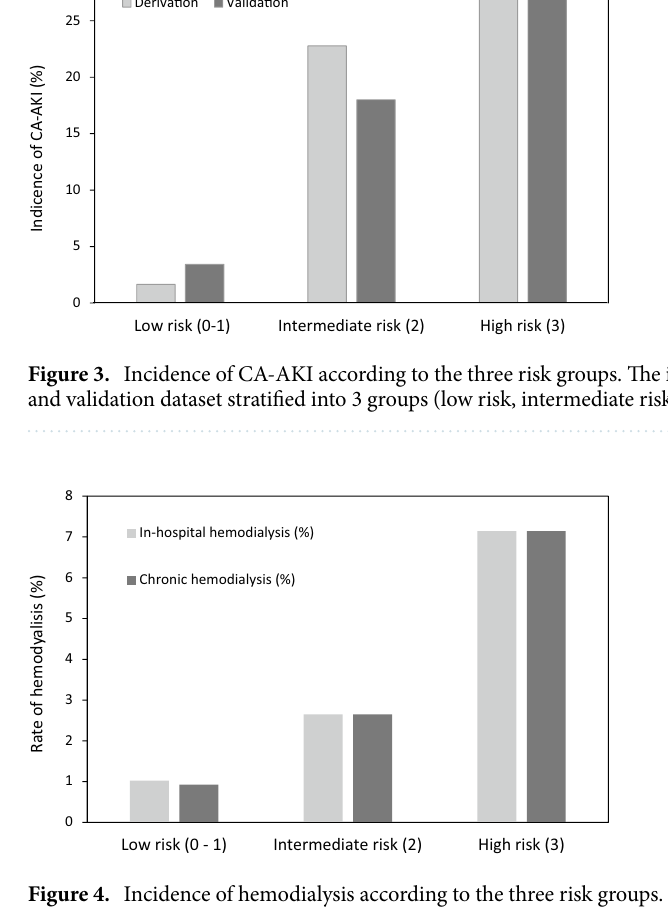
Figure 4. Incidence of hemodialysis according to the three risk groups. The incidence of in-hospital and chronic hemodialysis in the total dataset stratified into 3 groups (low risk, intermediate risk, and high risk) is shown.